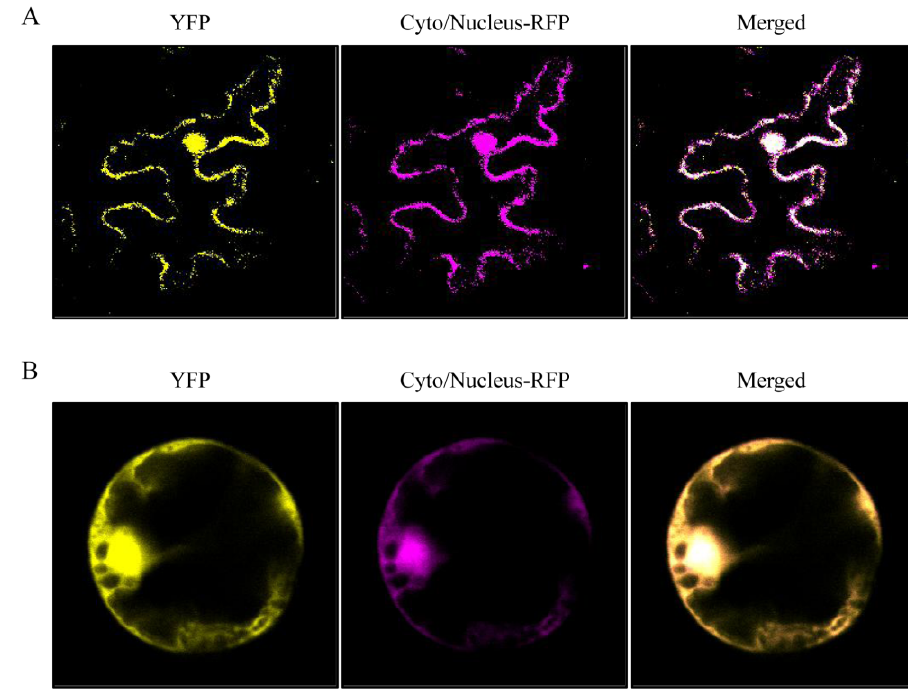
Figure 3. Subcellular localization of NlHSC70-3. ( A ) The NlHSC70-3-YFP fusion protein was ex- pressed in the N. bethamiana nucleus and cytoplasm. C-terminal yellow fluorescent protein (YFP) fusion with NlHSC70-3 lacking its endogenous signal peptides. Cyto/Nucleus-RFP marker and NlHSC70-3-YFP fusion protein were co-expressed in N. bethamiana . ( B ) Cyto/Nucleus-RFP marker and NlHSC70-3-YFP fusion protein were co-expressed in rice protoplasts by polyethylene glycol- mediated transformation.